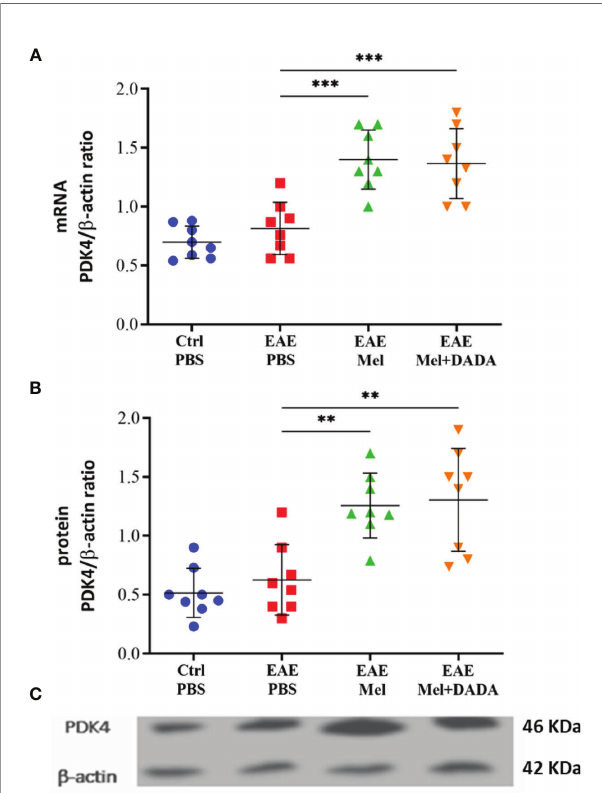
FIGURE 6 | Expression of PDK4. PDK4 levels after administration of melatonin with DADA in brain homogenates (A) mRNA expression levels of PDK4 assessed by real time-PCR. (B, C) Protein expression levels of PDK4 assessed by western blot. b -actin was used as an internal control for normalization for both real time-PCR and western blot. PDK4 expression levels was normalized to controls. Signi fi cance is indicated by **p < 0.01 and ***p < 0.001.